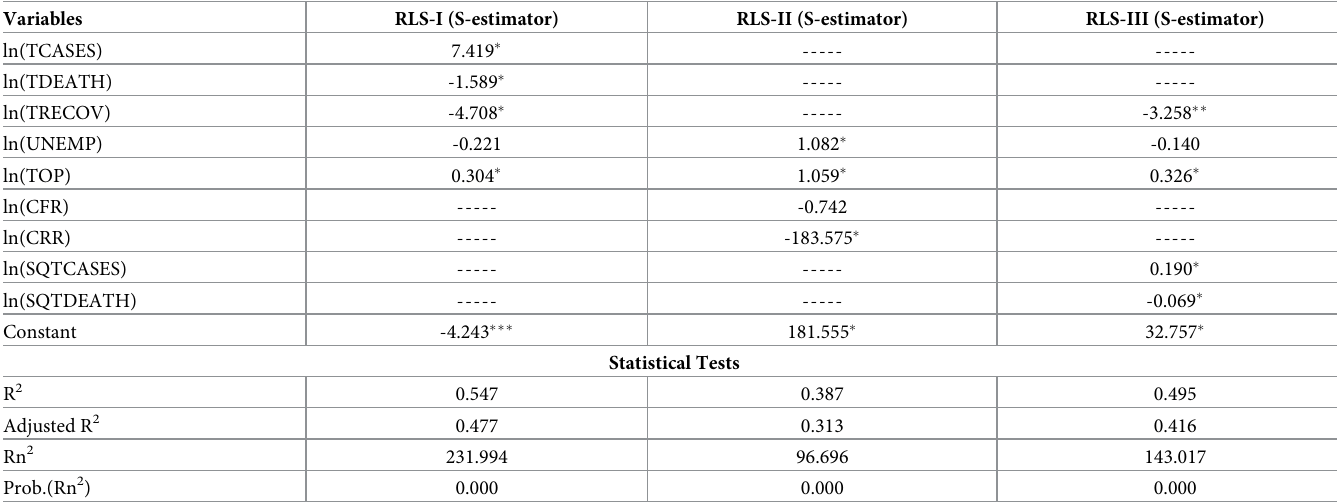
Table 5. Robust least squares regression for